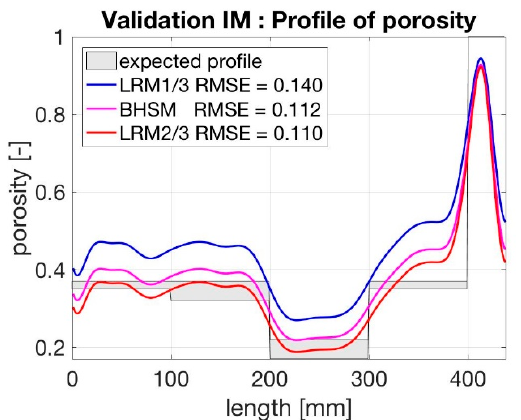
Figure 10. Porosity profiles calculated with the two mixing equations and two different values for the